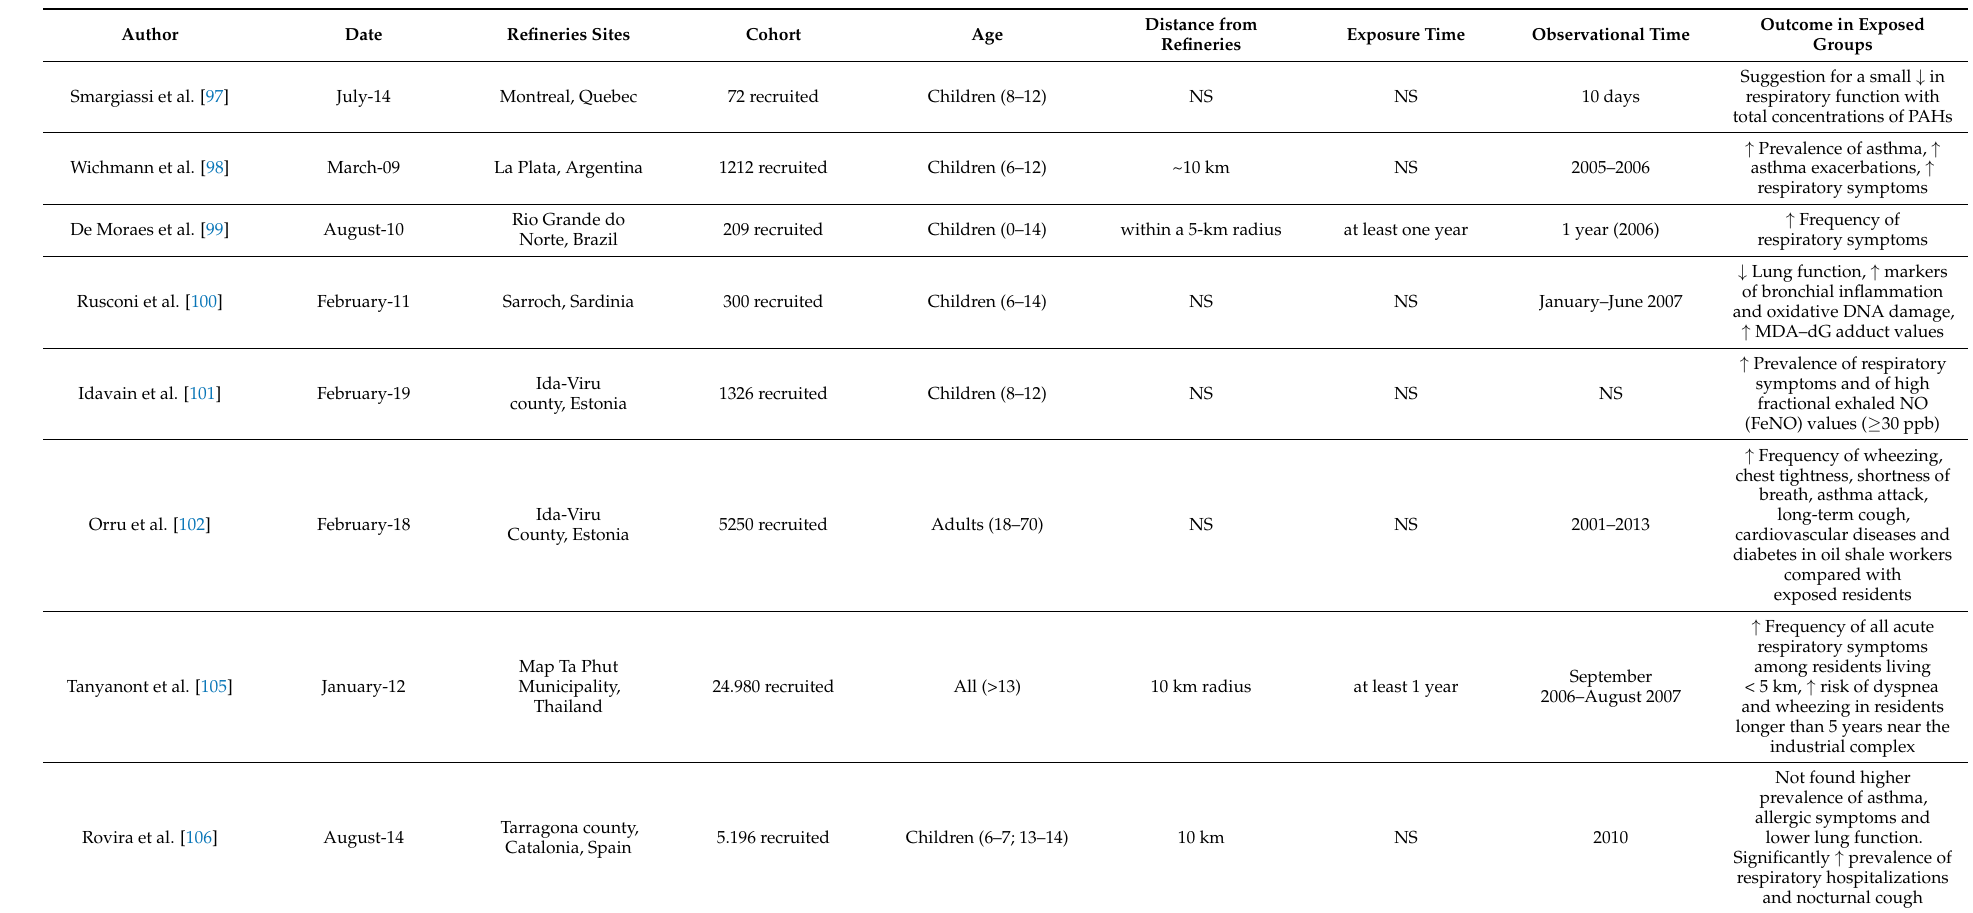
Table 2. Main hypersensitivity studies and their characteristics found through our